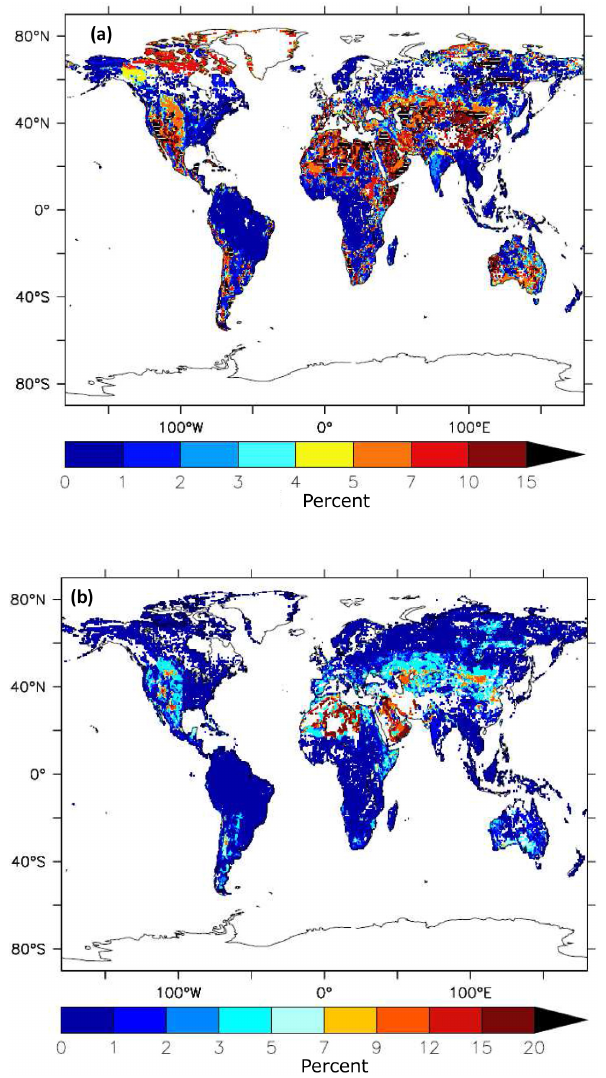
Fig. 6. Calcite content (a) in the clay fraction of soils (CASE 1) and (b) in the silt fraction of